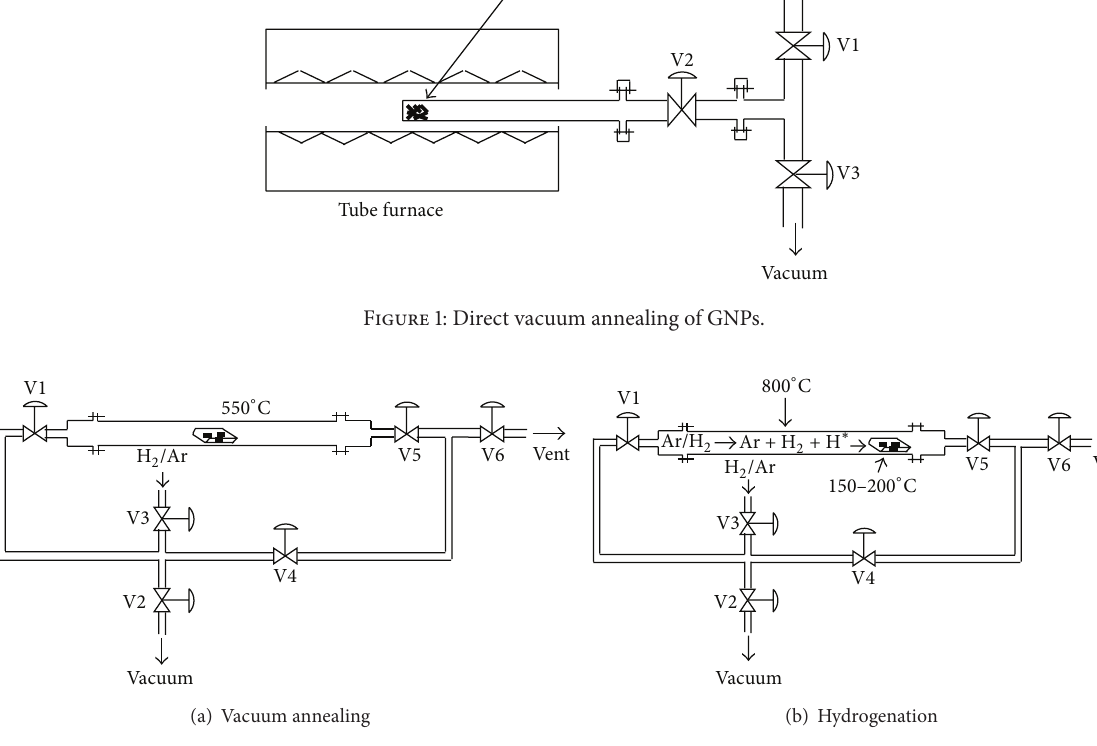
Figure 2: Two-step treatment of